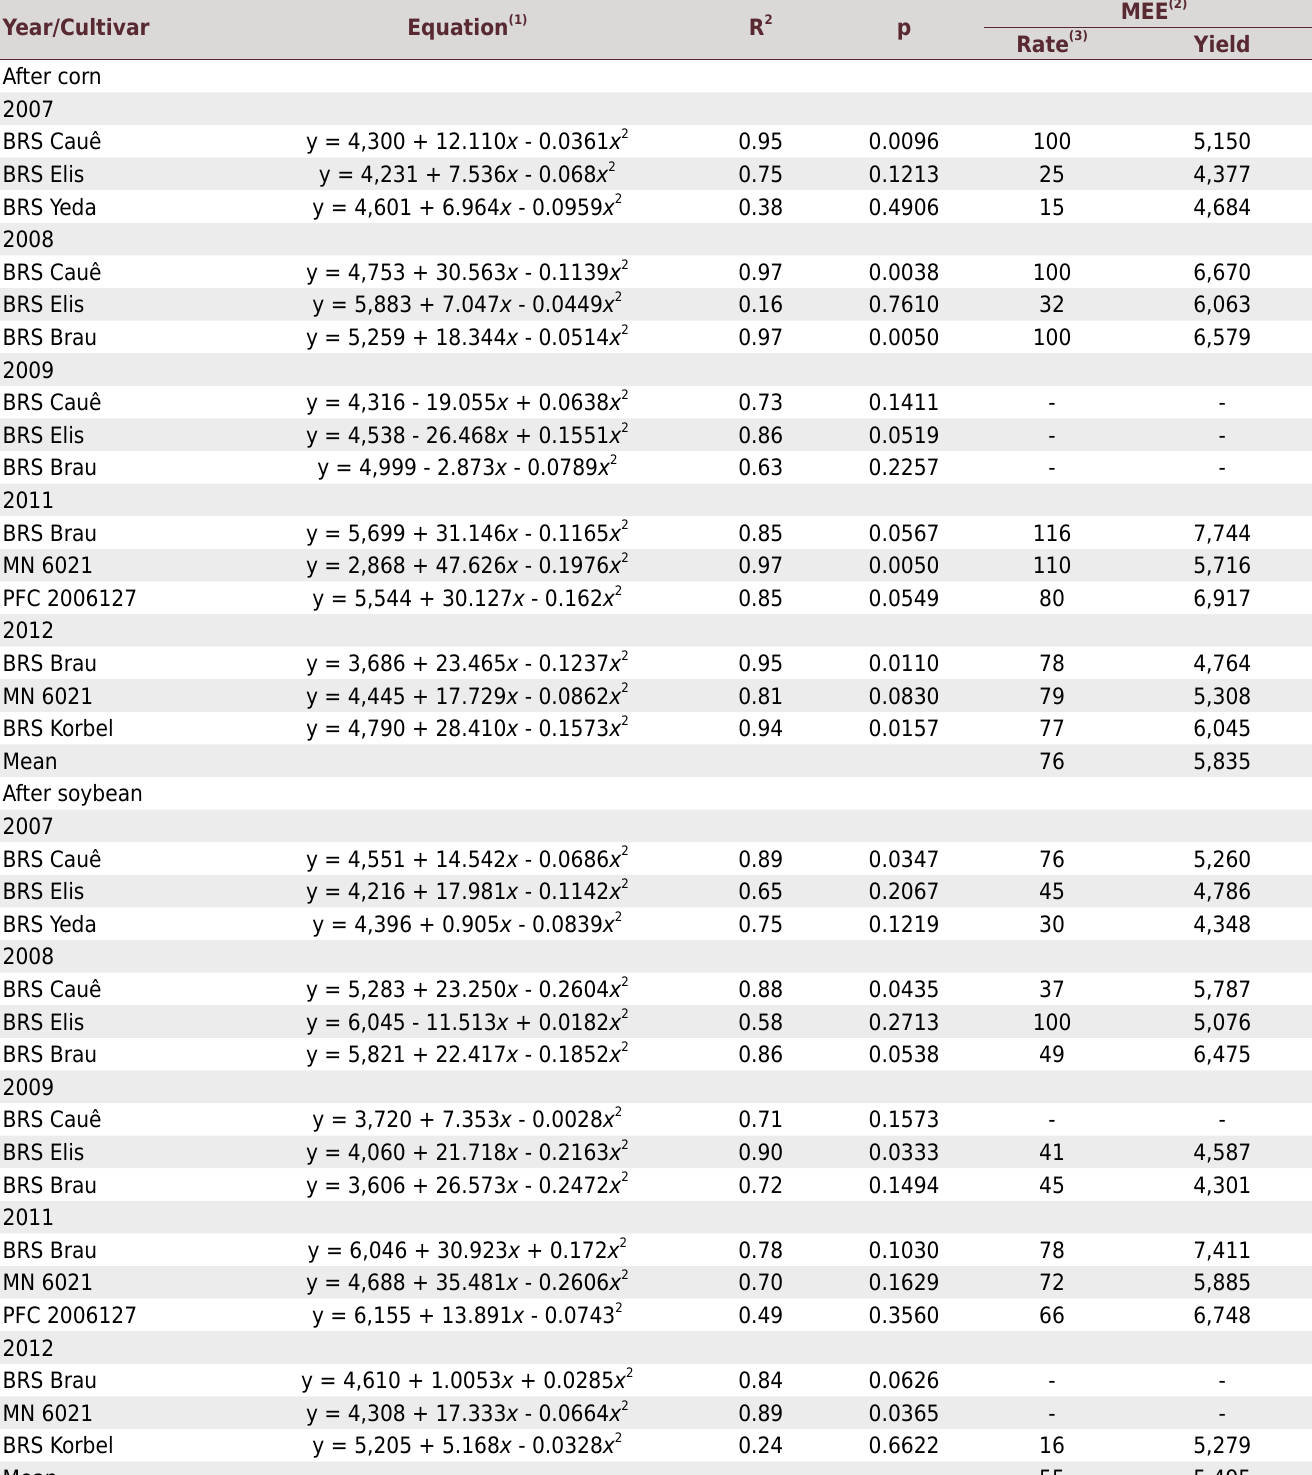
Table 6. Fitted equation of grain yield for barley grown after soybean and corn according to the applied urea-N rate (kg ha -1 ), maximum economic efficiency (MEE) rate, and respective yields